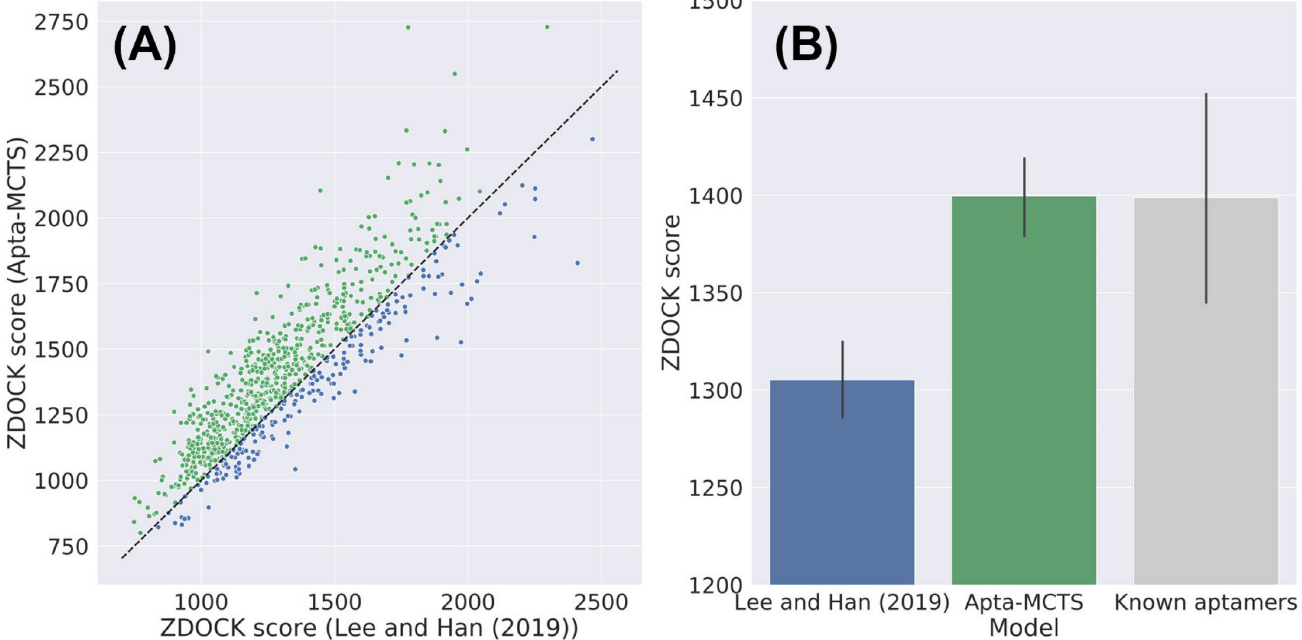
Fig 5. Binding affinity of aptamer samples that have same length with the known aptamers using the docking simulation score by ZDOCK. (A) Comparison of docking scores between our Apta-MCTS and the method employed by Lee and Han [21]. The diagonal dashed line indicates that the docking scores of both models are tied. Green dots above the diagonal line refer to how Apta-MCTS generated better aptamers with higher docking scores than the method used by Lee and Han [21]. (B) Comparison with known aptamers. Apta-MCTS showed the highest docking scores for this comparison.